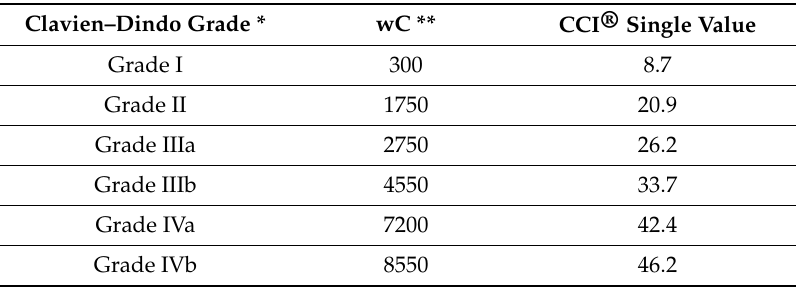
Table 2. The Comprehensive Complication Index